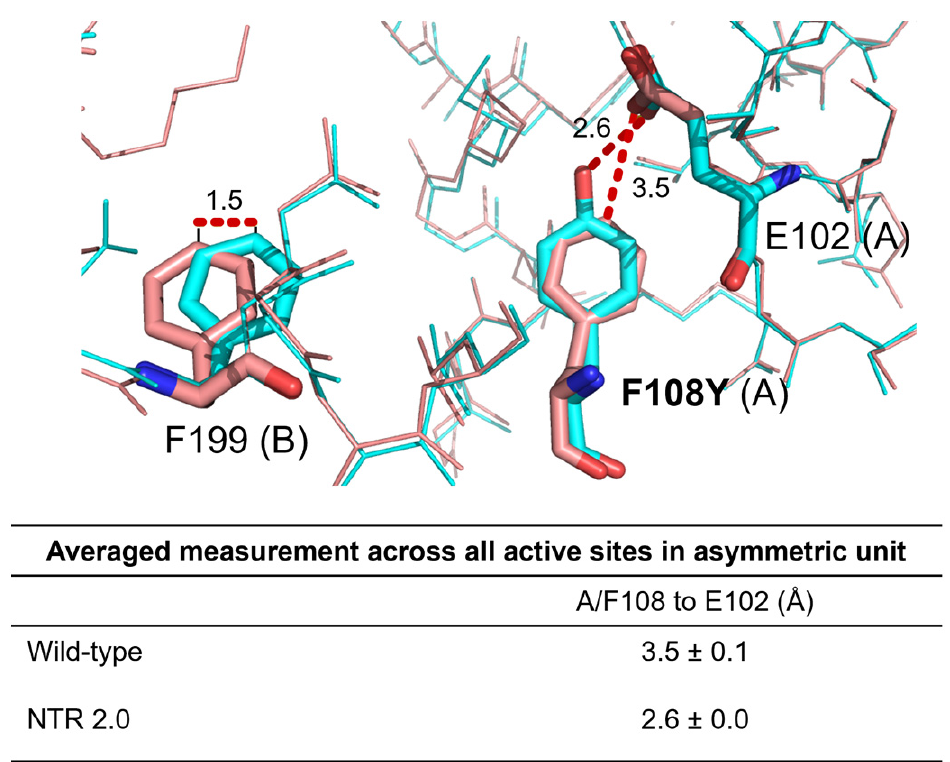
Figure 5. Residue 108 interactions in the active sites of NTR 2.0 and the parental enzyme. Residues at positions 102, 108 and 199 are shown as sticks and coloured red for unmodified V. vulnificus NfsB or cyan for NTR 2.0. Distance measurements are in Å. The distance between residue 102 and 108 was measured in PyMOL for each active site present in the asymmetric unit of each structure and the average measurement ± SD was calculated. Chain identity (A or B) is identified in parentheses after each numbered residue.